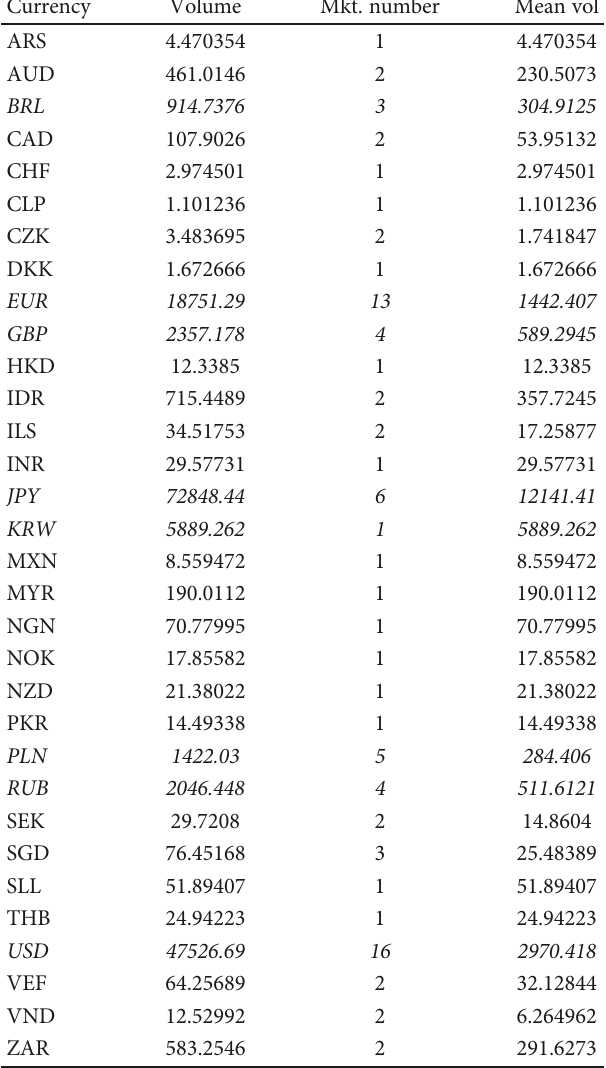
Table 1: Daily volume of di ff erent exchange rates. The volume is the average daily trading volume in 2017. Mean volume represents the average volume of the exchange rate for each market. The bold is the top 8 exchange rates which account for more than 98.35% market share. Currency